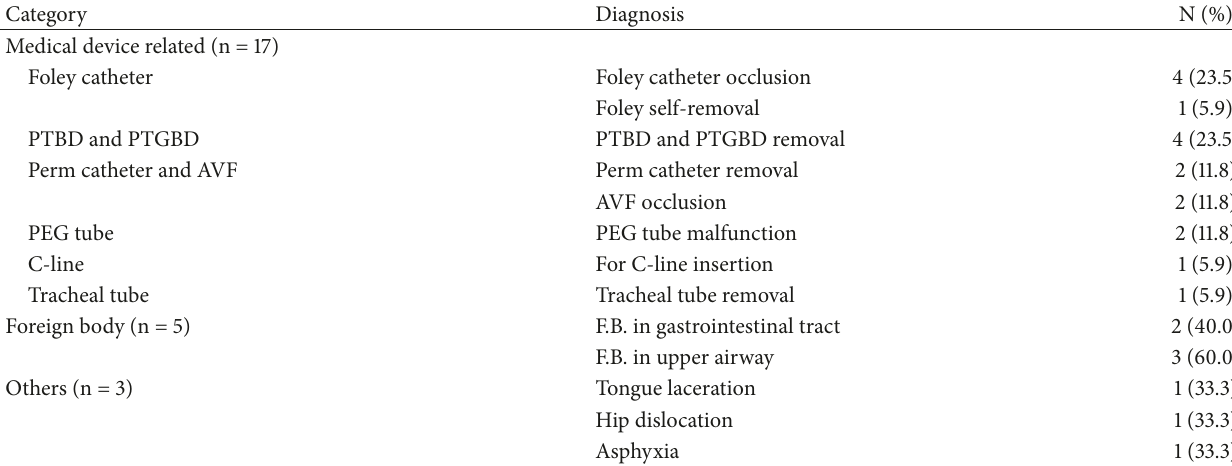
Table 3: Detailed histories of patients who transferred from long-term care hospital because of other nontraumatic